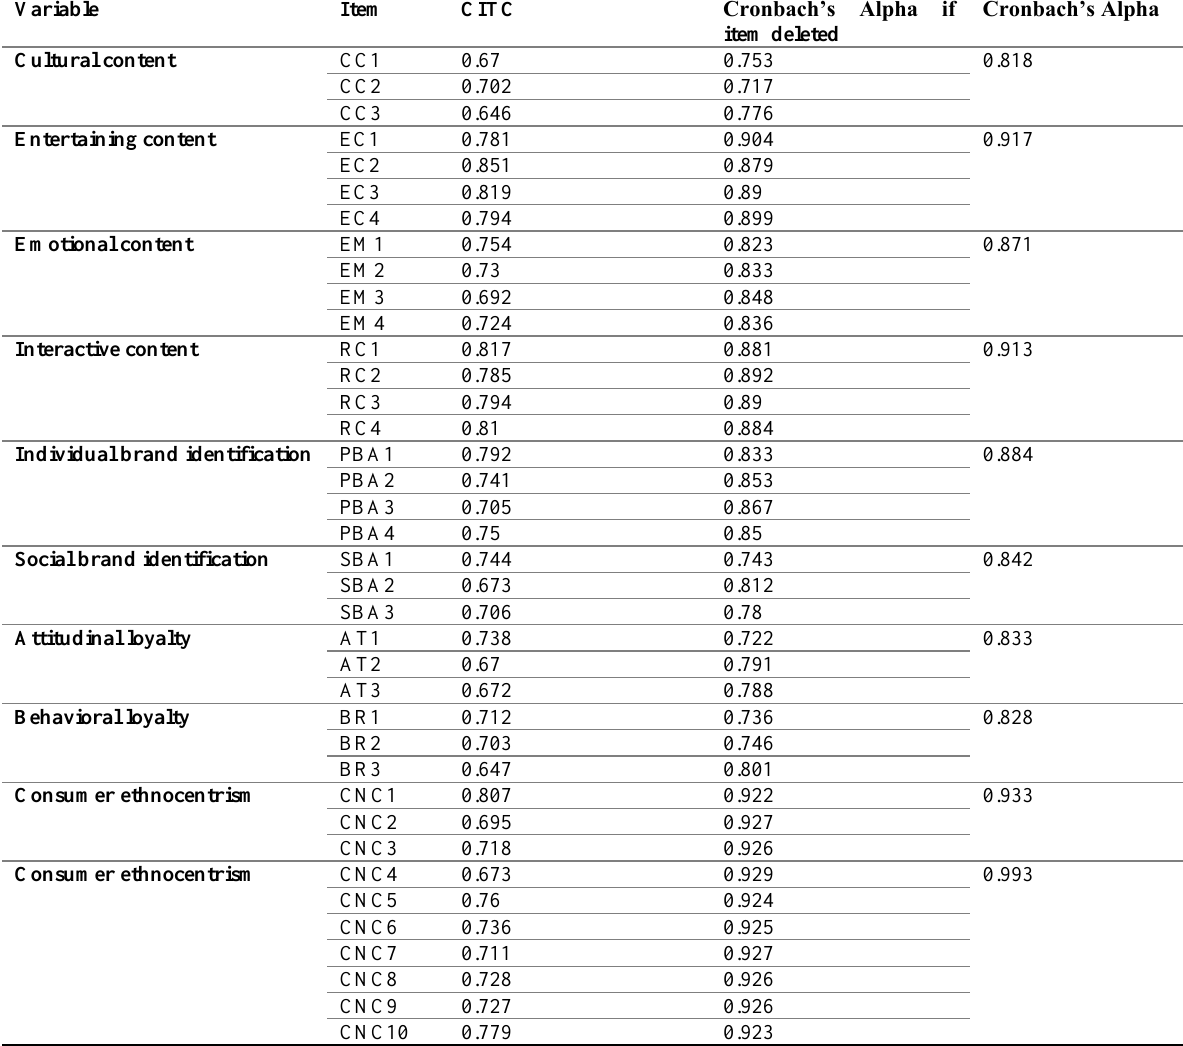
Table 1: Reliability analysis of the measured items